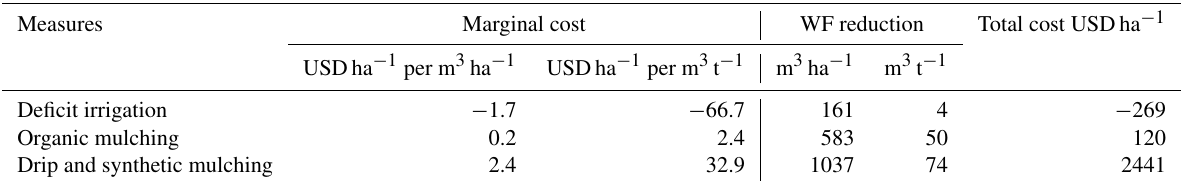
Table G1. Marginal cost and WF reduction per subsequent measure in the MCC for WF reduction in maize production for the baseline of furrow irrigation combined with full irrigation and no mulching.